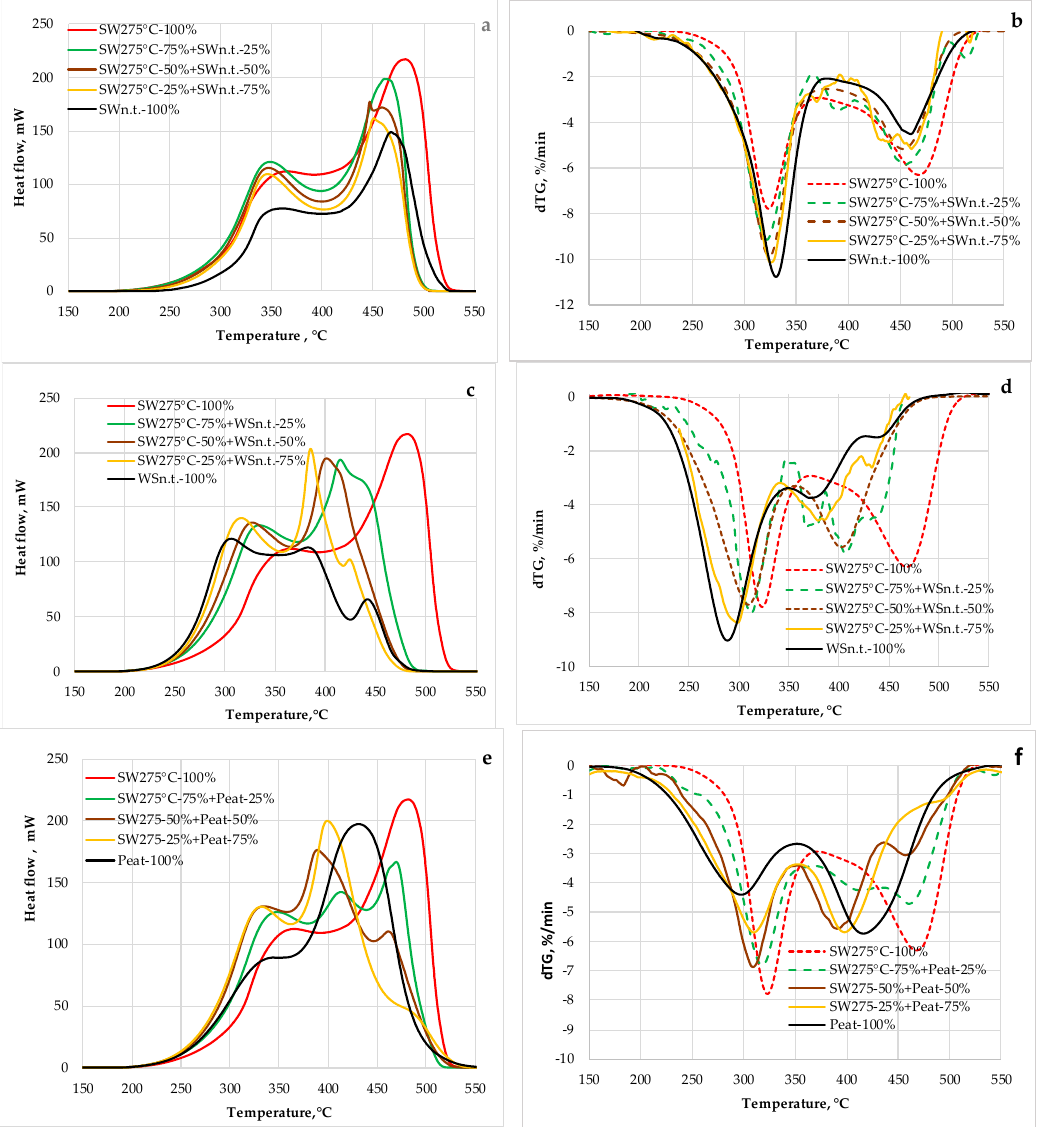
Figure 8. The DSC ( a , c , e ) and DTG ( b , d , f ) curves of binary blends containing MW pre-treated softwood and non-treated biomass of different origination.